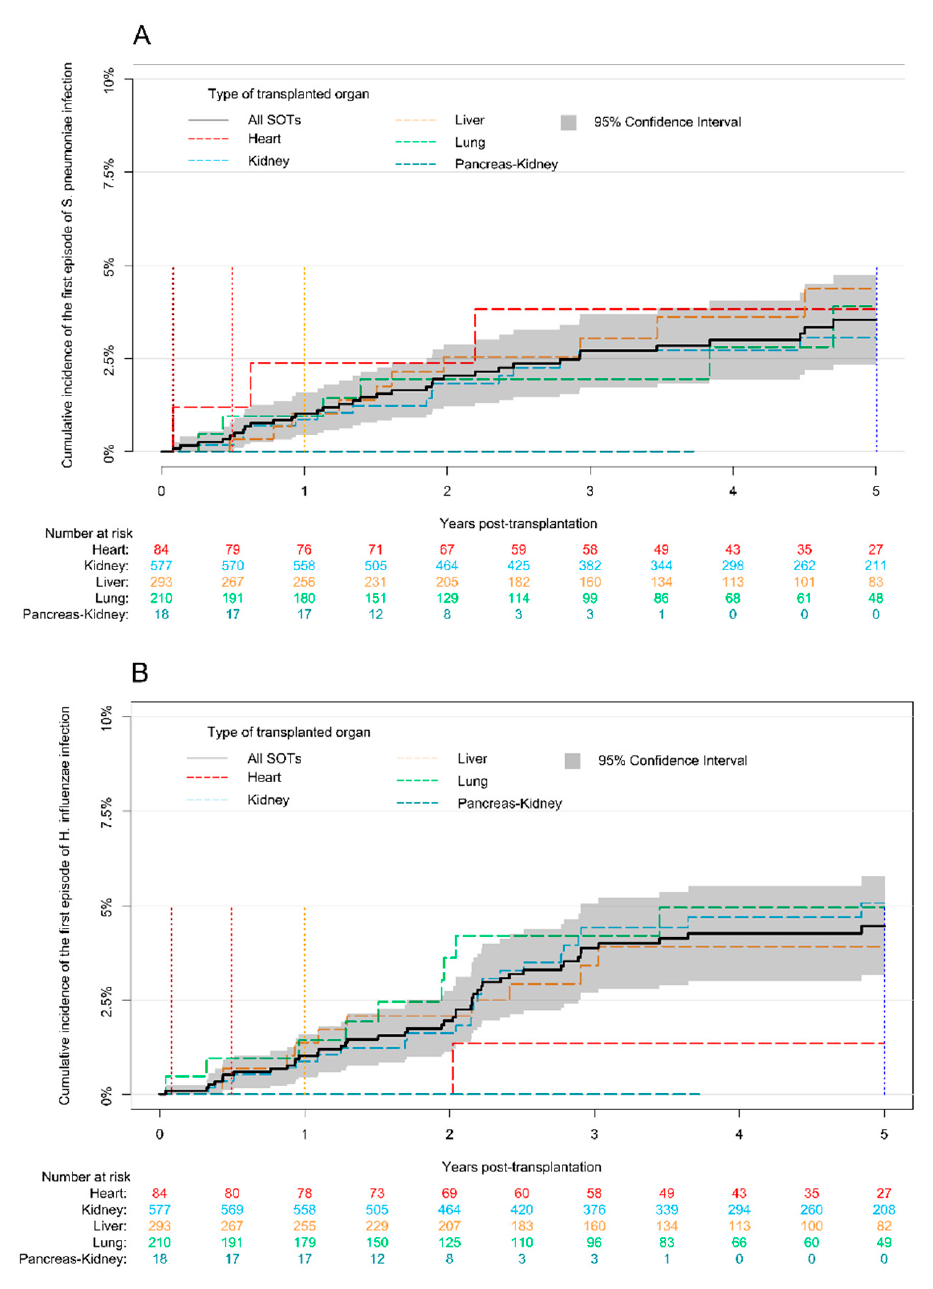
Figure 1. Cumulative incidence of the first episode of S. pneumoniae and H. influenzae infections during the five years post-transplantation. ( A ) Cumulative incidence (3.9% (95% CI, 0.63–7.2)) of the first episode of S. pneumoniae infection. There was no statistically significant difference in cumulative